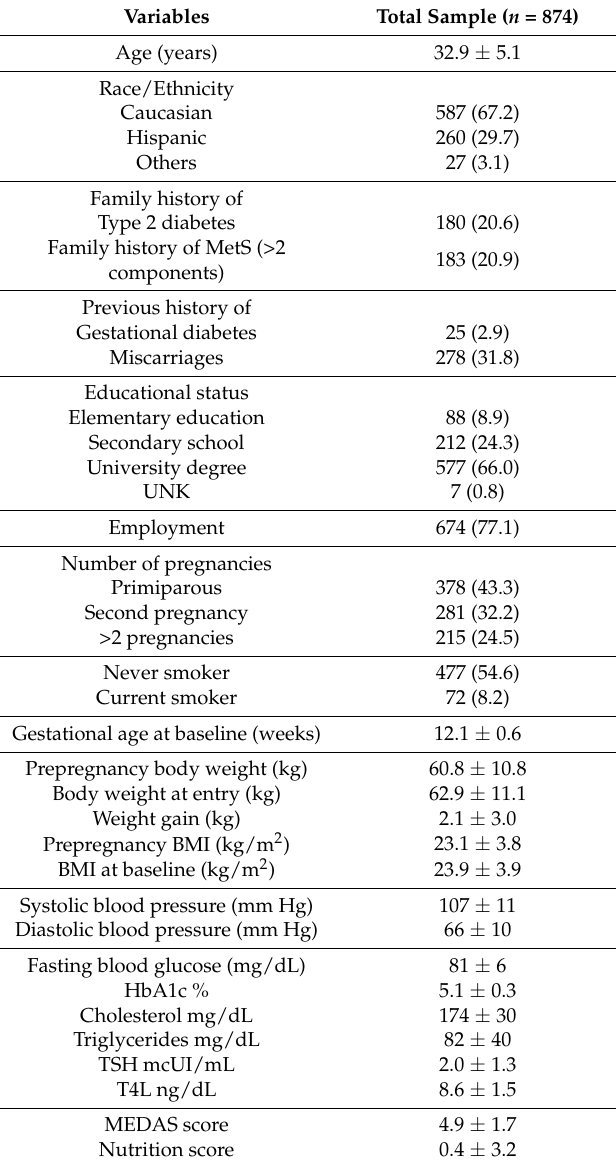
Table 1. Characteristics at baseline of all